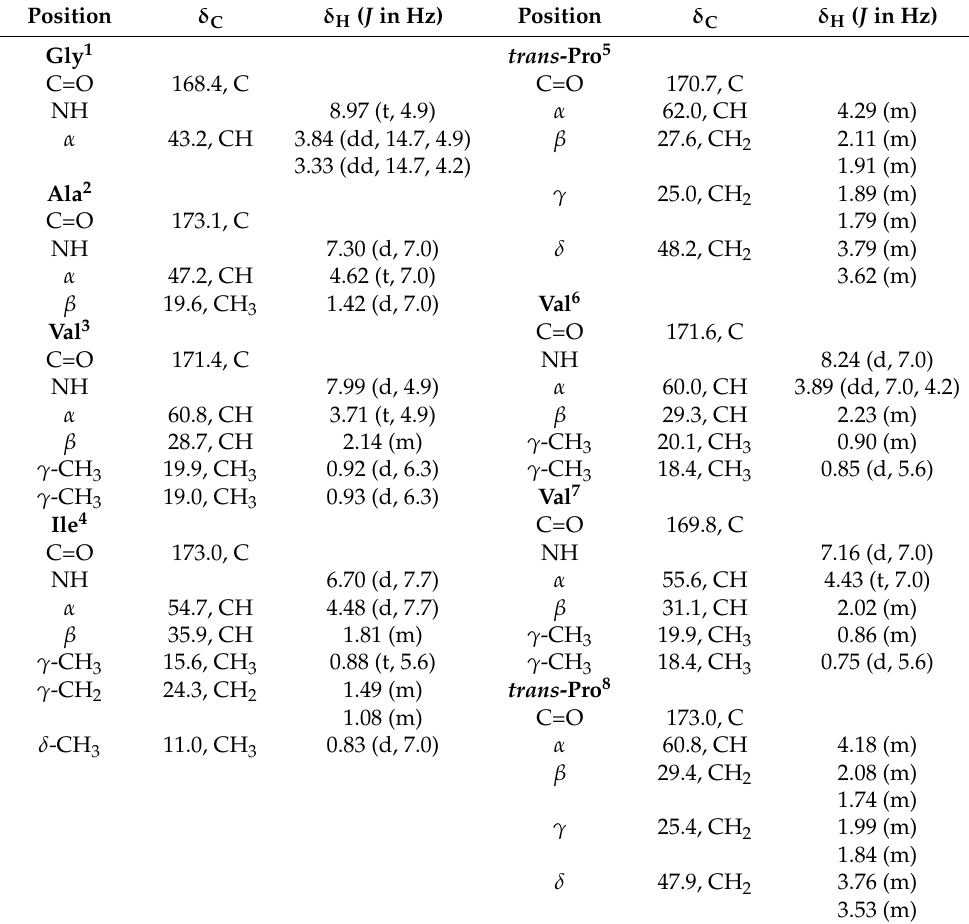
Table 4. 1 H and 13 C NMR data for dianthiamide D ( 4 ) (DMSO- d 6 , 700 MHz, d in ppm, J in